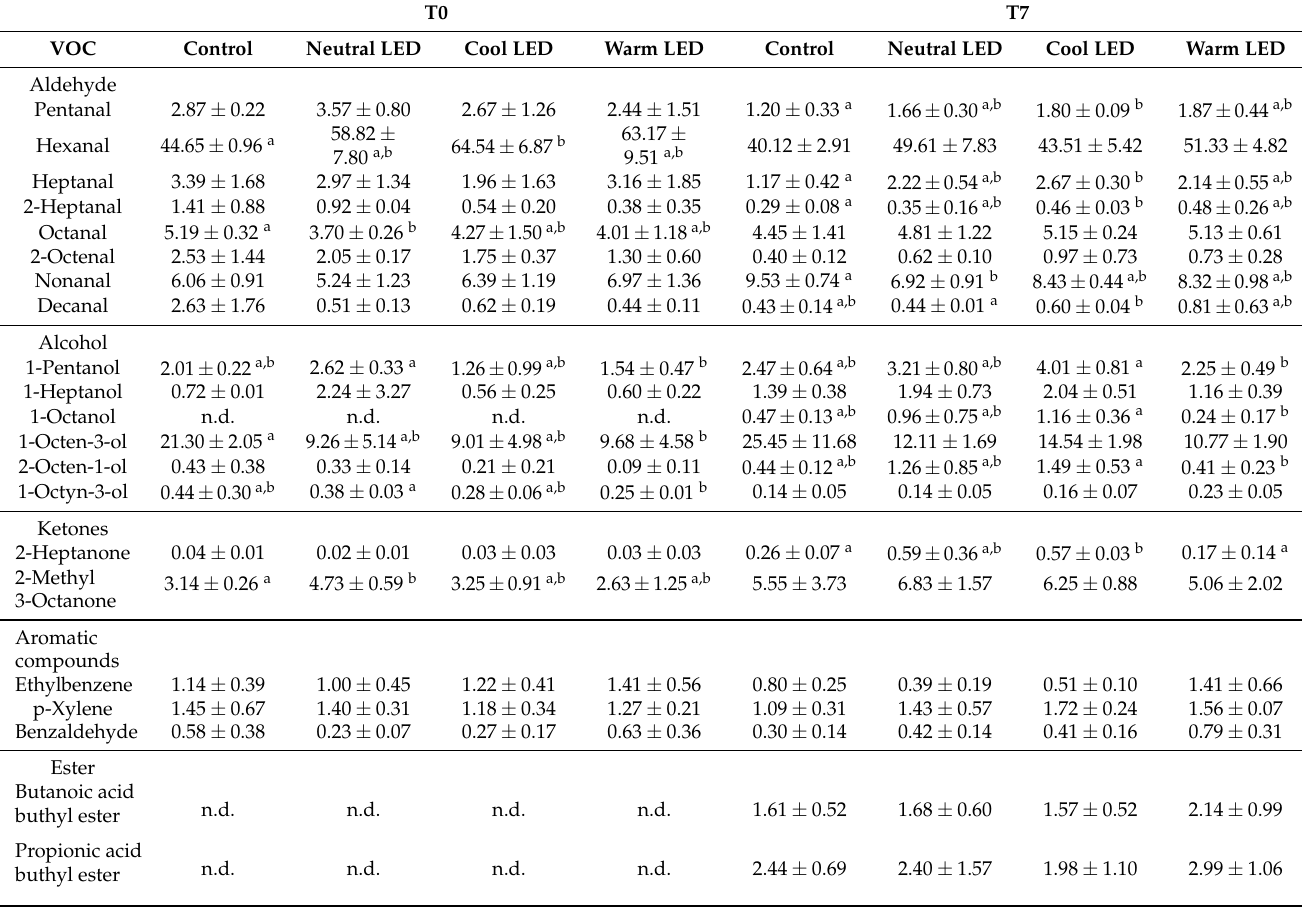
Table 3. Volatile profile of cooked breast meat samples obtained from red chickens exposed to different light treatments. T0